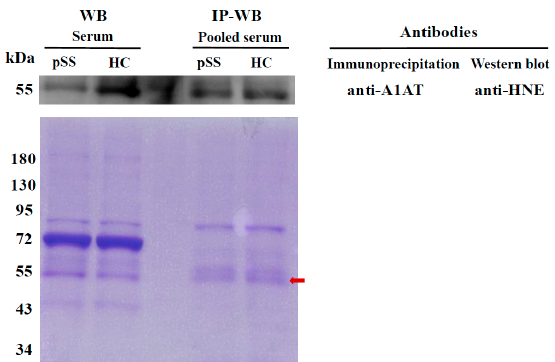
Figure 2. 4-Hydroxy-2-nonenal (HNE) modification of the serum A1AT protein was validated using immunoprecipitation (IP) and Western blotting. A1AT was immunoprecipitated from pooled serum samples (40 patients with primary Sjögren’s syndrome (pSS) and 40 healthy controls (HCs)) using anti-A1AT antibodies and then subjected to Western blotting with anti-HNE antibodies (upper panel). Individually selected random serum samples (patient with pSS and HC) were used as controls; these were simultaneously used for Western blotting with anti-HNE antibodies. A duplicate gel was stained with Coomassie brilliant blue as a loading control (bottom panel). The red arrow indicates the A1AT